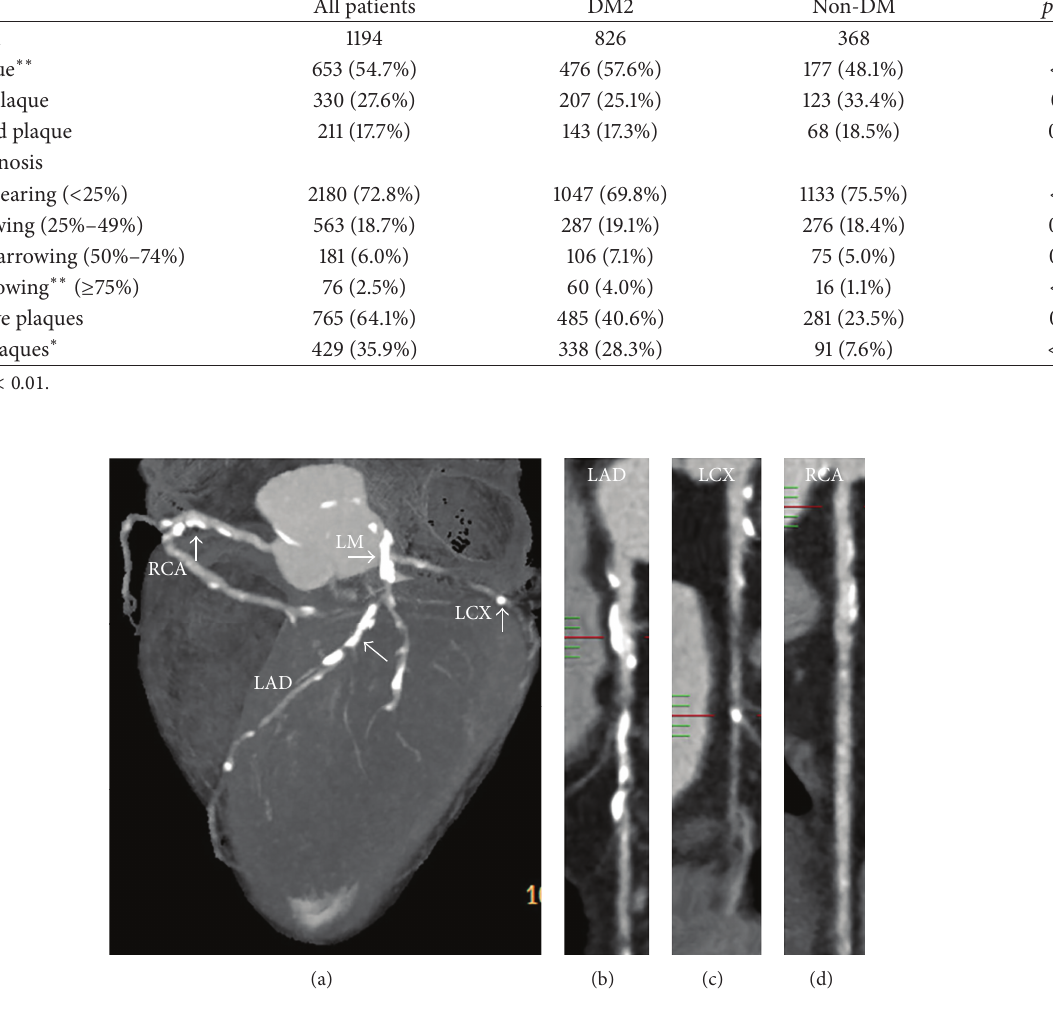
Figure 3: A 62-year-old man with 17 years’ history of diabetes with multivessel disease. (a) Volume rendering image depicts unsmooth edges for left and right coronary vessels. (b), (c), and (d) show diffuse calcified plaques and multiple stenosis distributed in the whole course of the LAD, LCX, and RCA arteries